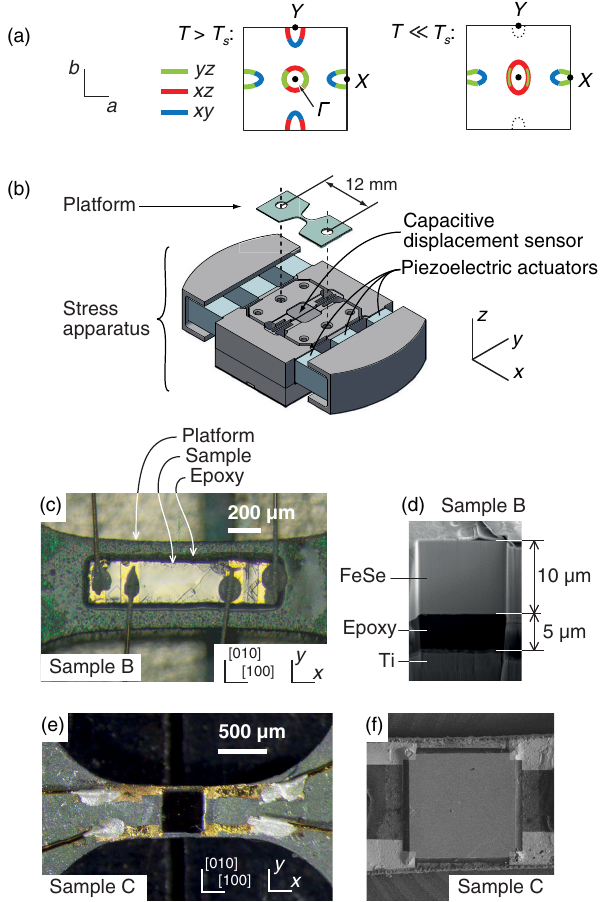
FIG. 1. (a) Schematic illustration of the electronic structure above and below the nematic transition temperature T surfaces are colored by their dominant orbital content. For T < T , k is oriented along the crystalline a axis, where s x a > b . (b) Piezoelectric uniaxial stress apparatus with a platform. (c) Photograph of sample B, with contacts attached for measuring resistivity along the sample ’ s length. The lattice directions are indicated. Sample Awas prepared similarly, though with its crystal axes rotated by 45°. (d) Scanning electron (SEM) micrograph of a cut, made with a focused ion beam, through sample B and the epoxy layer beneath it. (e) Photograph and (f) SEM micrograph of sample C, which was prepared in a Montgomery